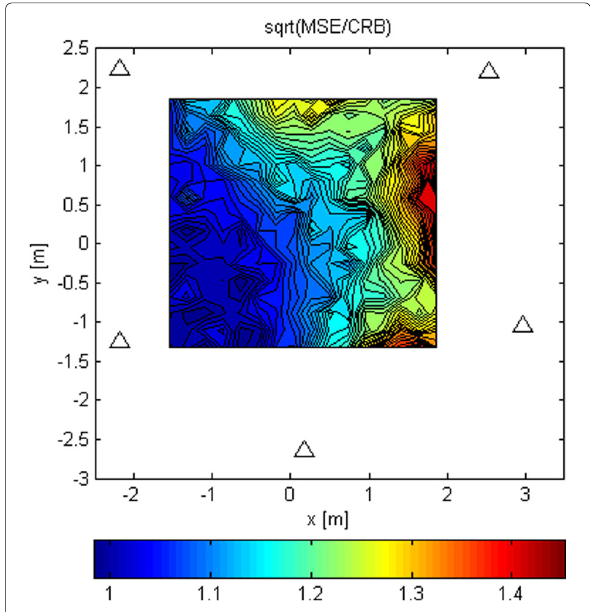
Fig. 19 MSE/CRB of stage 3 and N = 1024 when the main lobe is not